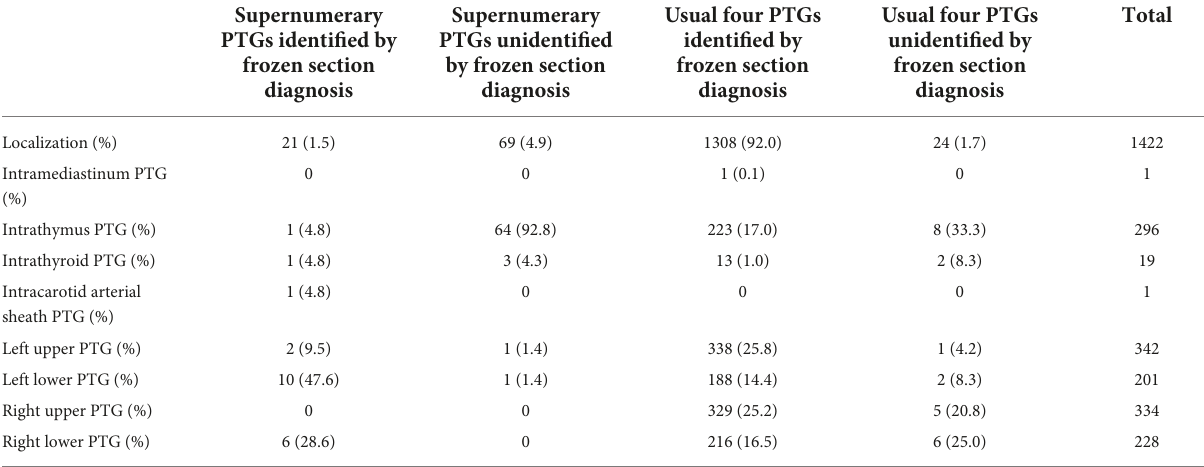
TABLE 8 Localization of parathyroid glands and identification by frozen section diagnosis in all parathyroid glands confirmed by final paraffin section diagnosis. Supernumerary PTGs identified